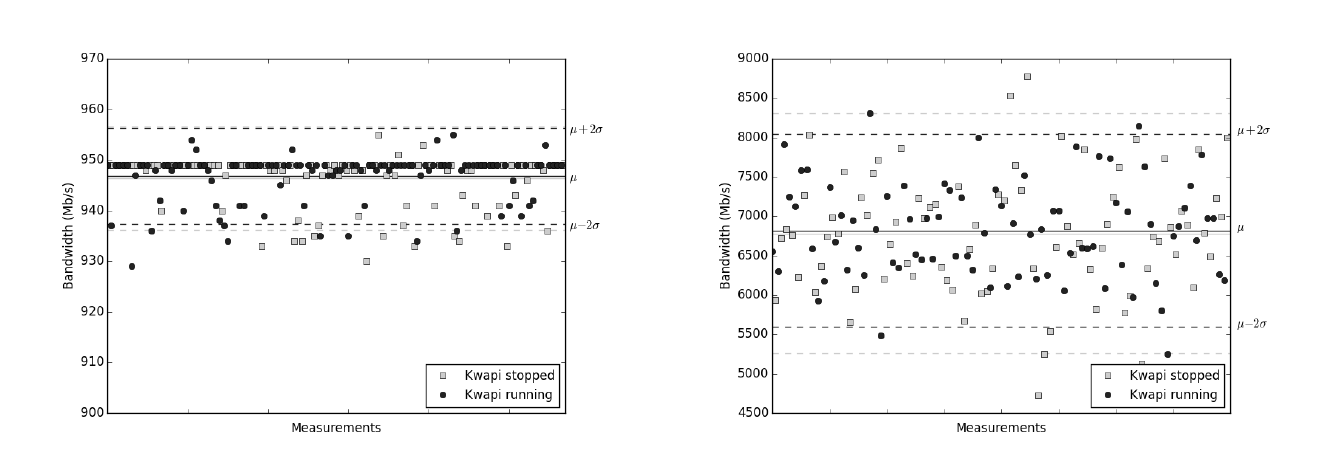
Figure 6: Measurements of network bandwidth between nodes with/without Kwapi running, for a 1G cluster (left panel) and a 10G cluster (right panel). Solid lines represent the mean µ and dashed lines the 2 standard deviations σ from the